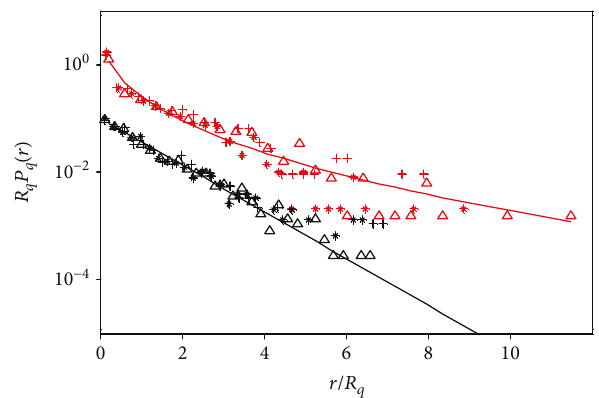
Figure 3: Normalized distribution density function R P r as q q . The return interval r for the thresholds q = 2 0 a function of r / R q ≈ 159 ), 2.5 ( ∗ R ≈ 363 ), 3.0 ( + R ≈ 632 ) for the simulated ( Δ R q q q long-term correlated records with γ = 0 4 (red symbols). Black symbols represent the rescaled distribution ( × 10 − 1 ) for the corresponding shu ffl ed data with same